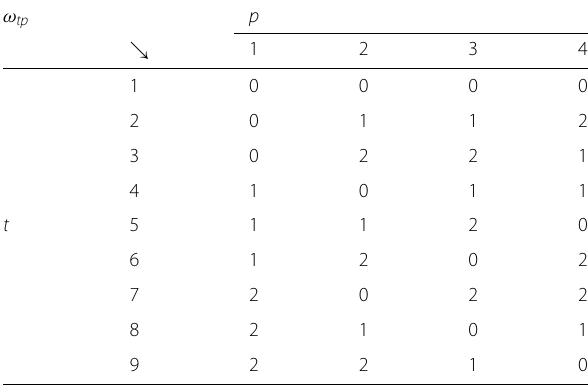
Table 1 SVR training. Example of OA ( L = 3, P = 4, T =